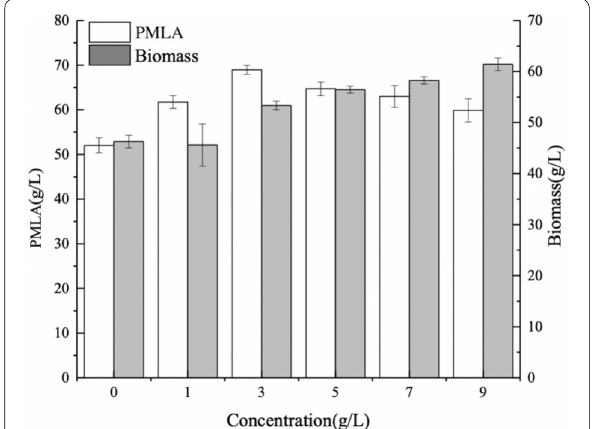
Fig. 1 Different concentrations of CSL on PMLA production and